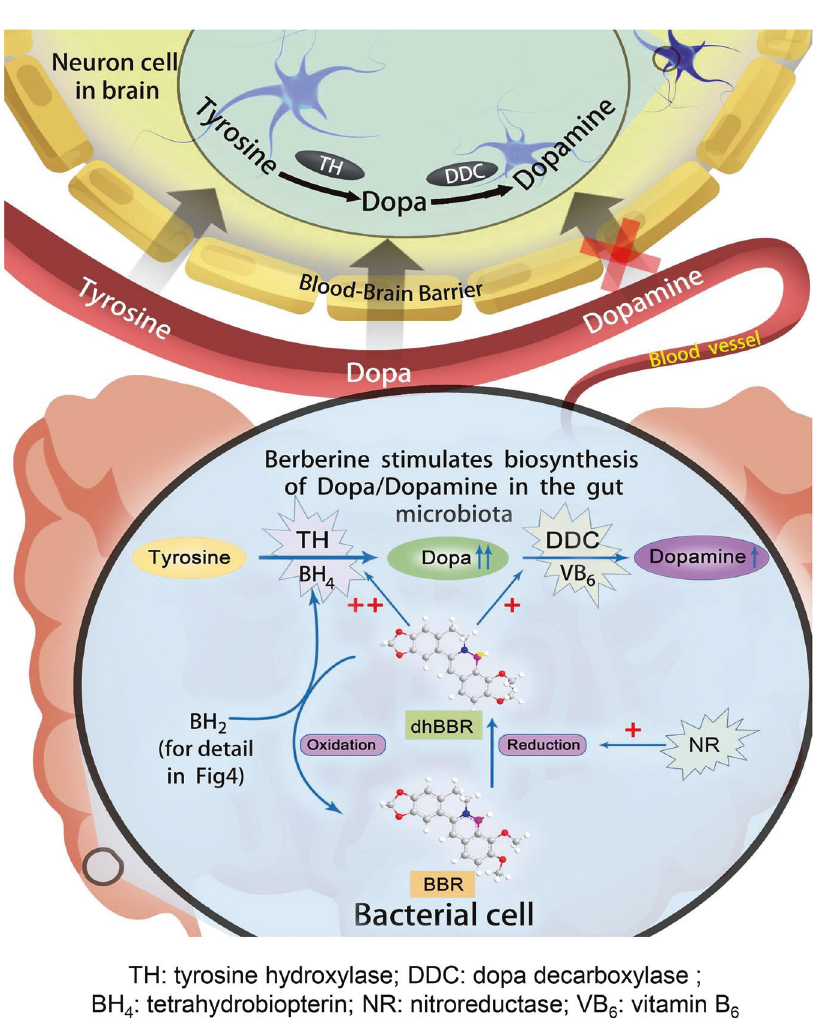
Fig. 7 Dopa/dopamine might be the chemical link for the crosstalk between gut and brain. The regulation of Phe – Tyr – dopa – dopamine biosynthesis in the gut microbiota by BBR could improve brain